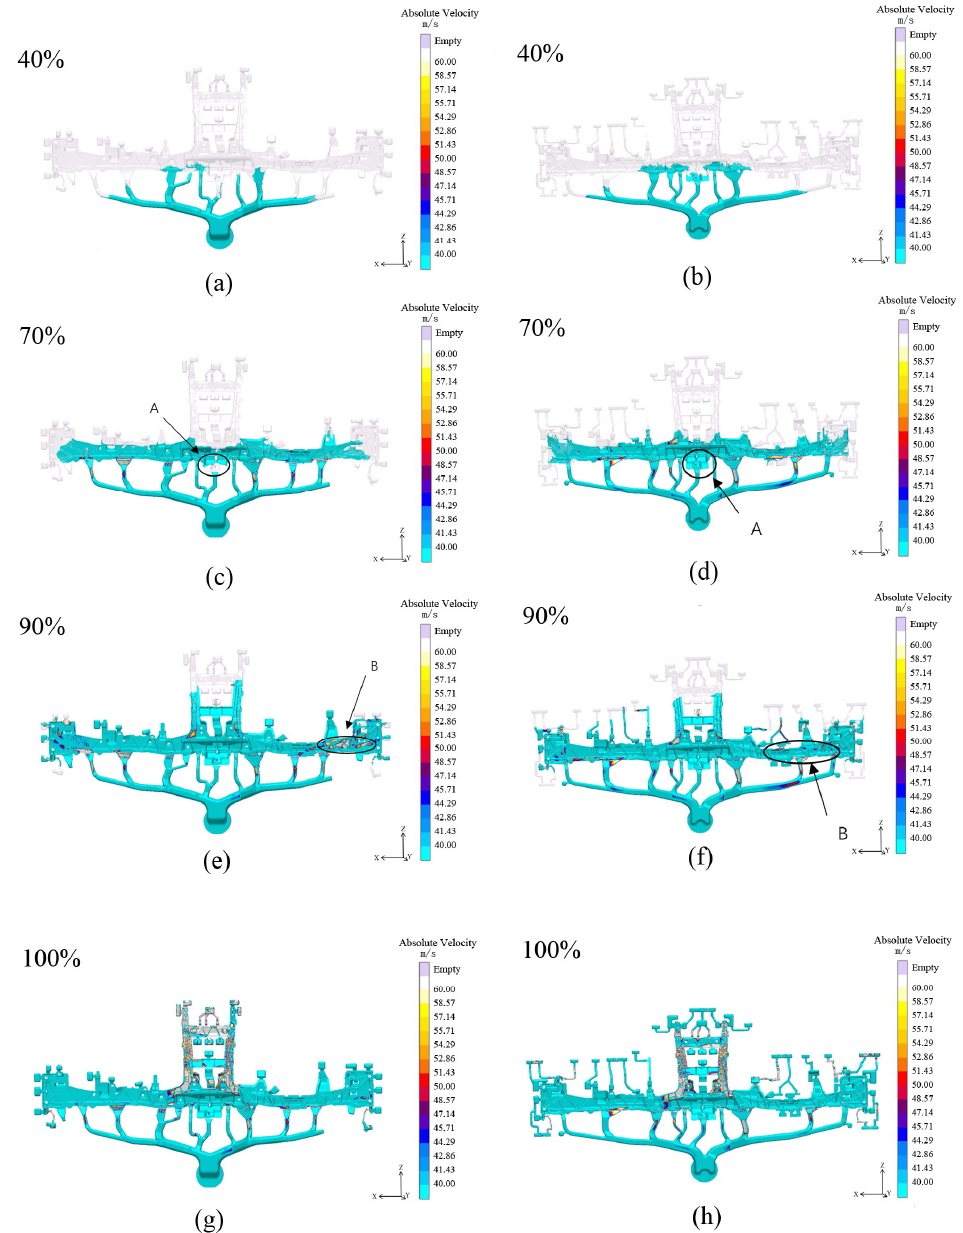
Figure 3. Filling velocity simulation results of the two projects: Scheme 1 ( a , c , e , g ); Scheme 2 ( b , d , f , h